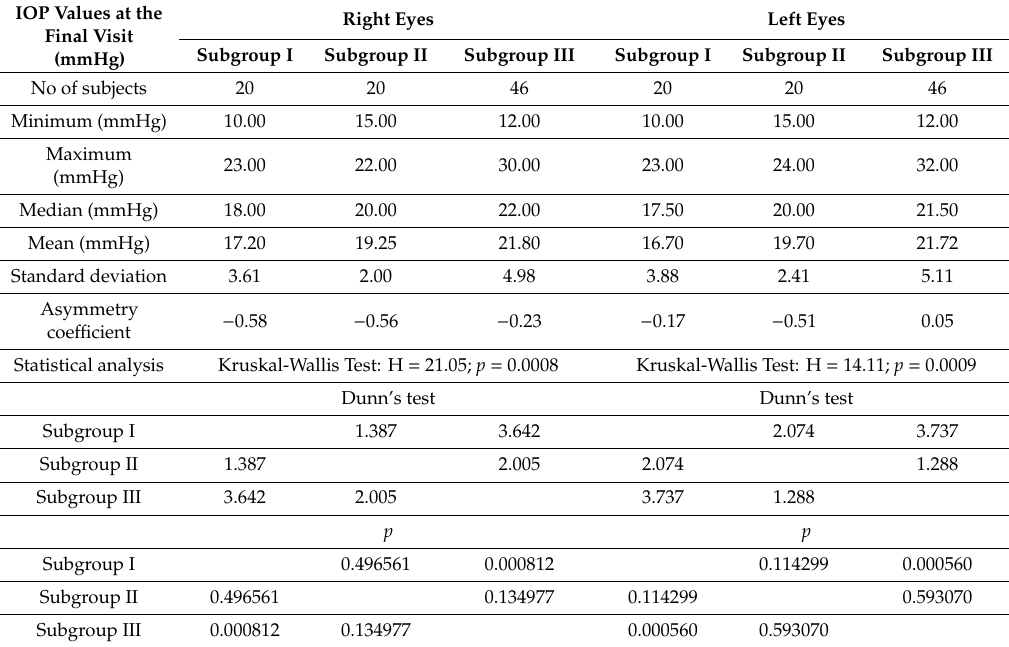
Table 8. IOP measurements values analysis in the study participant’s right and left eyes at the final visit. IOP Values at the Final